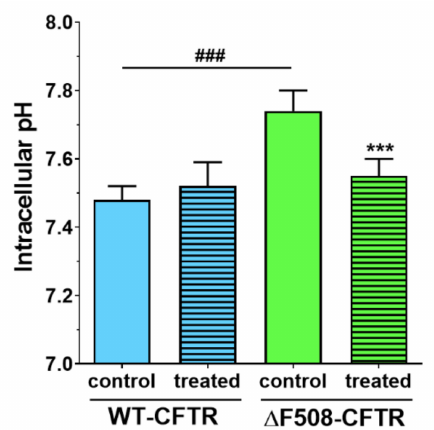
Figure 12. The e ff ect of sodium bicarbonate treatment on the resting intracellular pH of CFBE cells. The pH i of WT-CFTR and ∆ F508-CFTR CFBE cells after a 1-h treatment with bu ff er containing 26 mM (control group) or 100 mM sodium bicarbonate. Values are presented as means ± SD, n = 47–67. Statistical analysis: 2-way ANOVA followed by Bonferroni test. ### p < 0.001 compared to the wild-type epithelial cells, *** p < 0.001 compared to the control